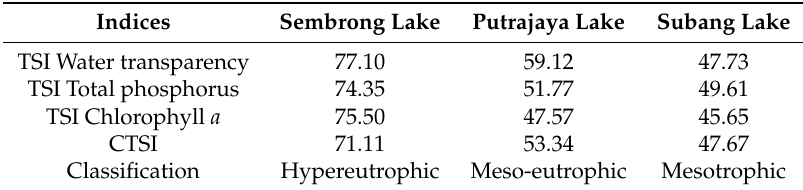
Table 2. Carlson trophic status index (CTSI) (Range: < 30–40 = Oligotrophic; 40–50 = Mesotrophic; 50–70 = Eutrophic; 70–100 + = Hypereutrophic) of lakes [24] based on water transparency, total phosphorus and chlorophyll a .